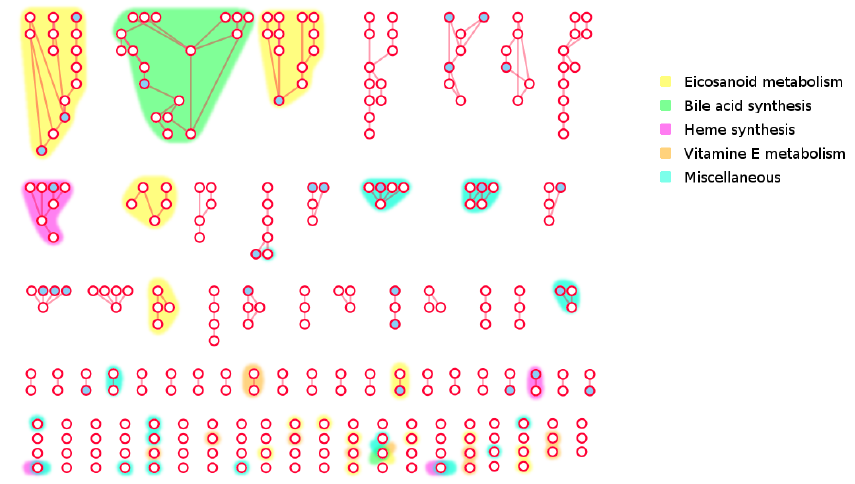
Figure 6. The ‘dark side’ of Human metabolism. The least covered subgraph of Recon 2.03 obtained from Label Propagation Algorithm (LPA) using mapping status as the initial state. White circles: Non-mapped metabolites. Blue circles: mapped metabolites. Edges: Substrate-product relationships. Metabolites with ambiguous identifier have been removed. Colored Hulls: Pathways overrepresented in the poorly mapped area of the human metabolic network Recon 2.03. Right-tailed Fisher exact test with Benjamini-Hochberg correction, α = 0.05.